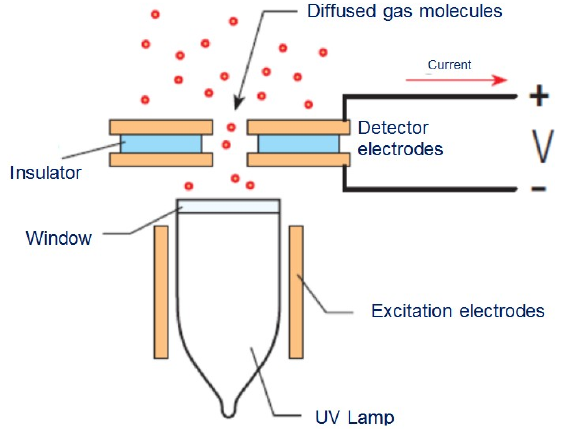
Figure 2. PID schematic.